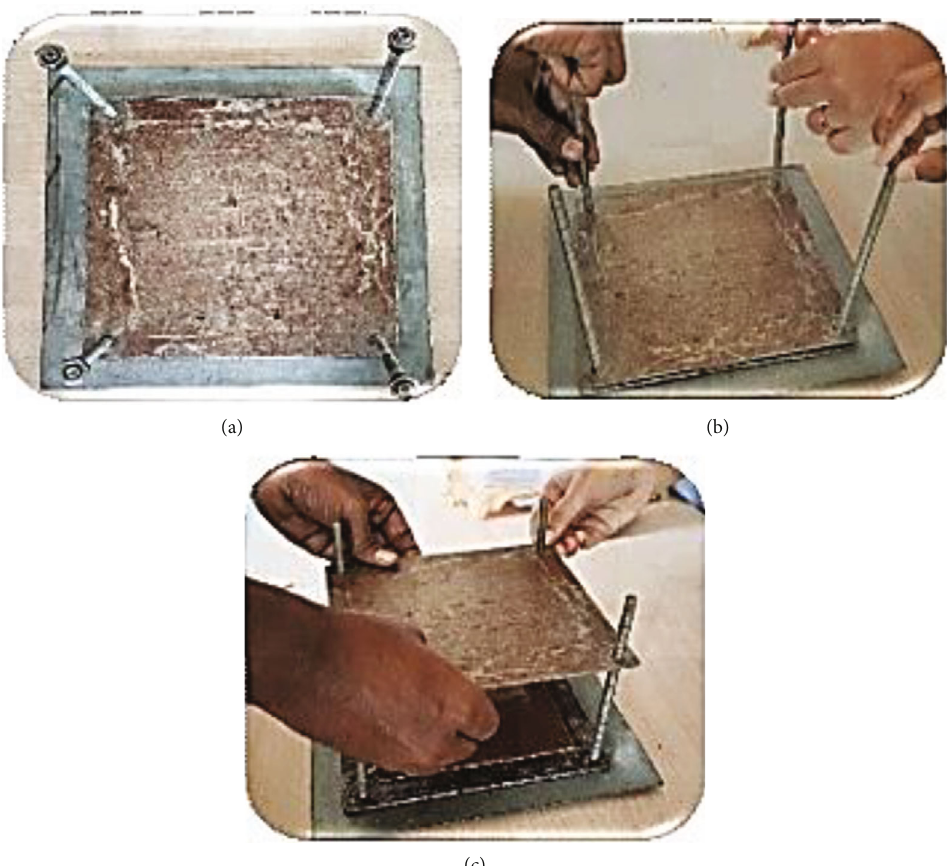
Figure 3: Fabrication of bio-based nanocomposites by using the hand layup method: (a) applying wax, (b) placing the woven mat, and (c) closing the mould.